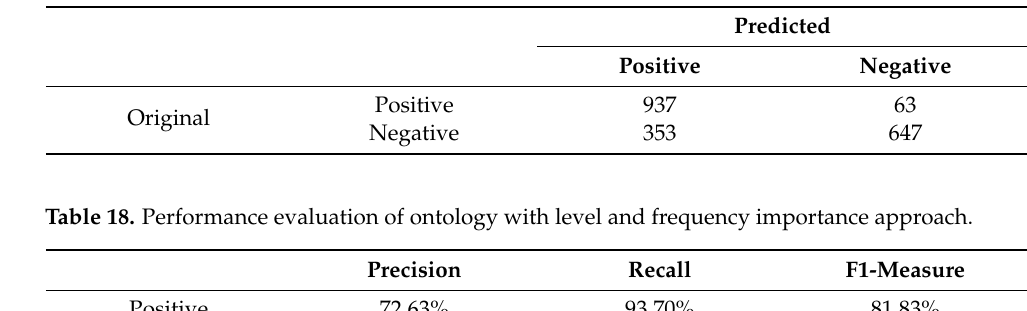
Table 17. Confusion matrix for ontology with level and frequency importance approach.